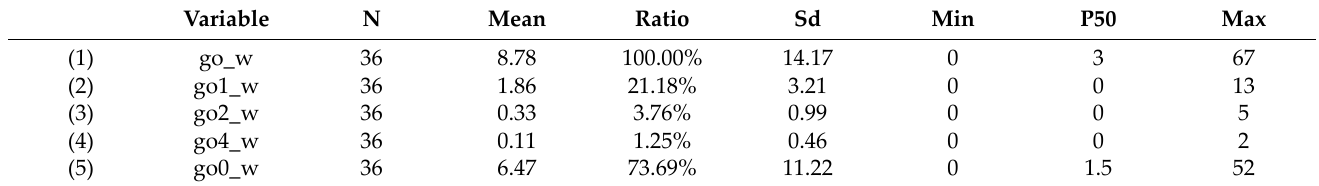
Table 8. Results of the analysis of the level‑2 government subdimension on social